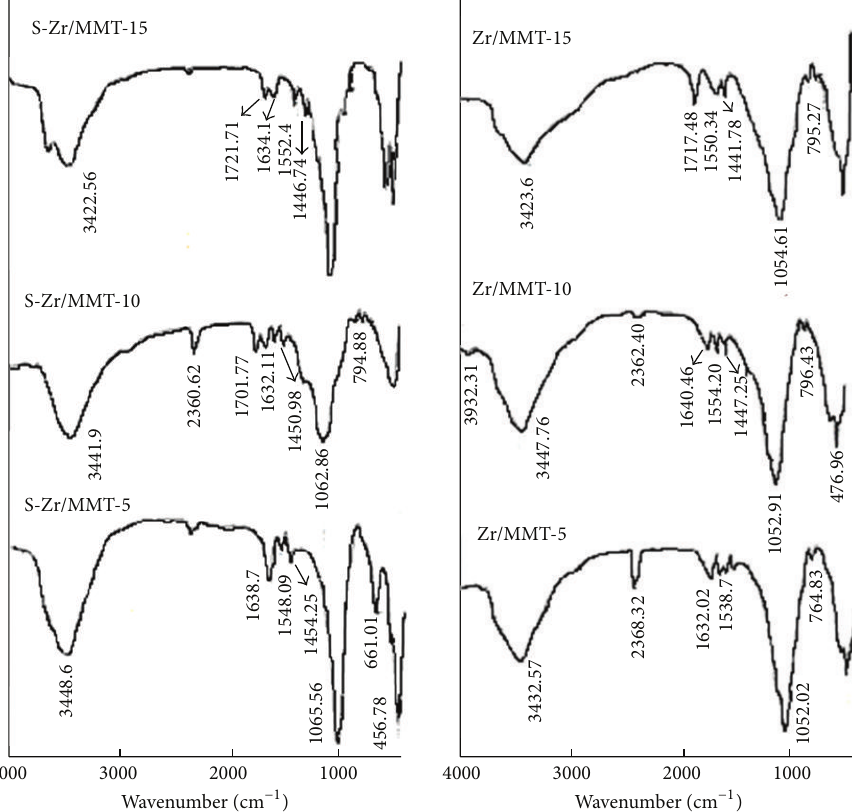
Figure 4: FTIR spectra of materials affect pyridine adsorption.